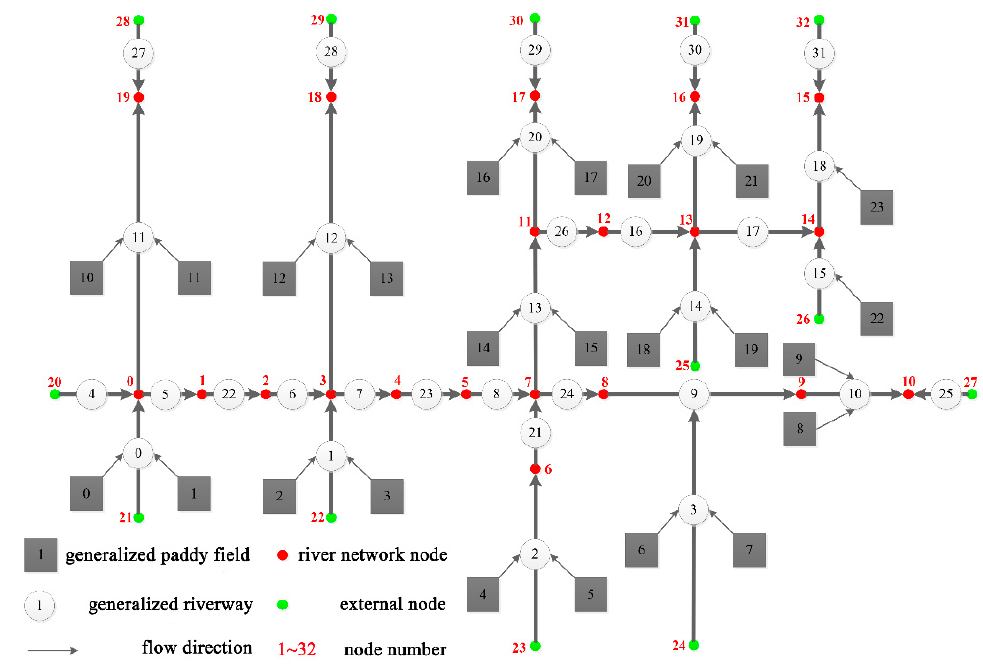
Figure 5. Flow chart of drainage system for waterlogging removal in the study area.